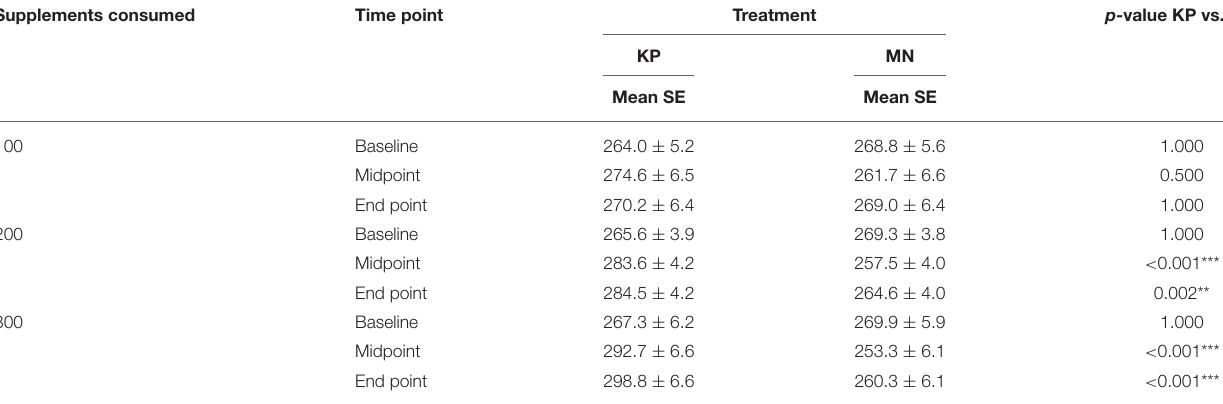
TABLE 3 | Estimated plasma BCAA concentration in different number of supplements consumed. Supplements